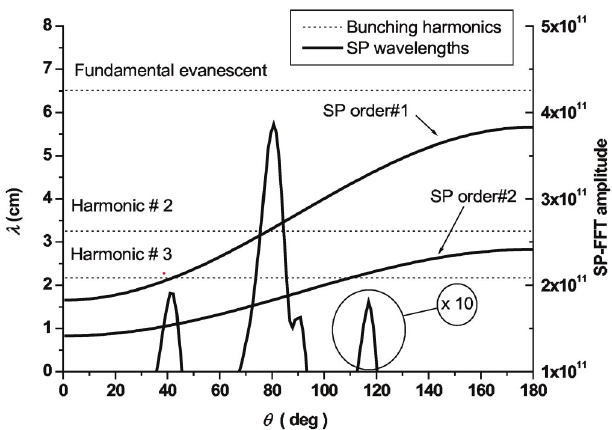
FIG. 5. Amplitude of the major FFT coefficients as a function of angle. Also shown are the first and second order SP wave- lengths as a function of angle, together with the wavelengths of the fundamental (evanescent), second, and third harmonics.